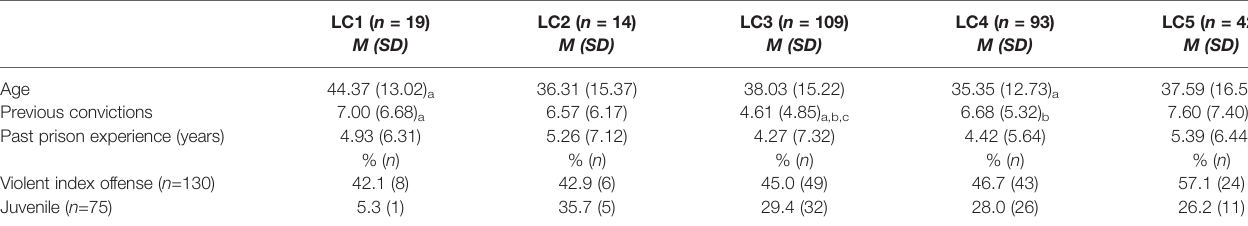
TABLE 3 | Criminological characteristics by latent